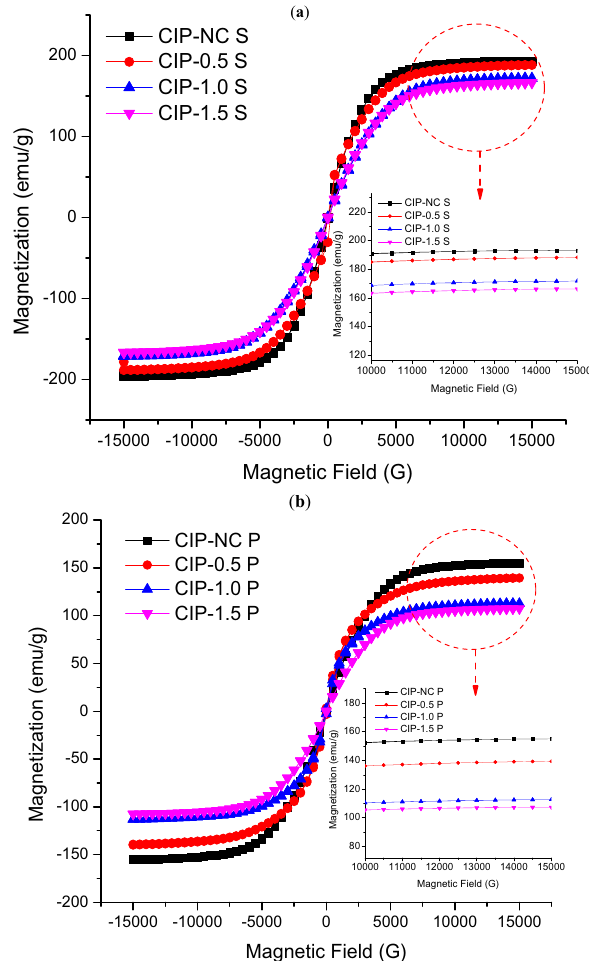
Figure 3. Magnetization curves of different shapes of CIPs ( a ) spherical CIPs and ( b ) plate-like CIPs as a function of magnetic field correspond to various concentrations of diluted